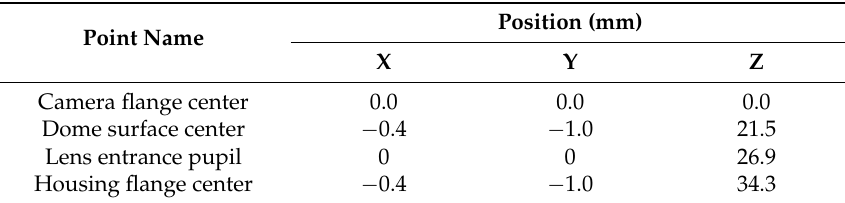
Figure 11. Two views of NI303D housing with NI320 dome port and reference planes and points. Table 4. Coordinates of key geometric and optic elements.